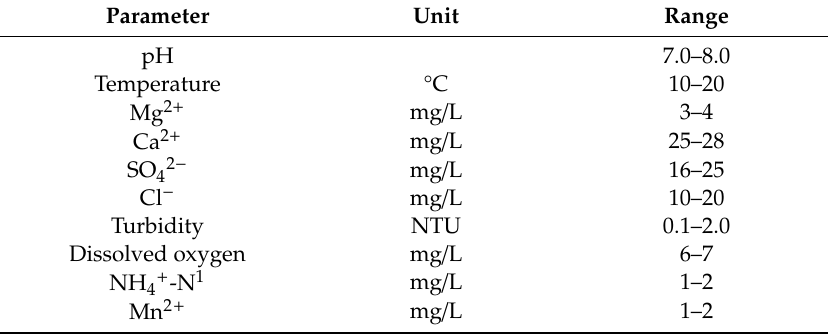
Table 1. Water quality parameters of the feed